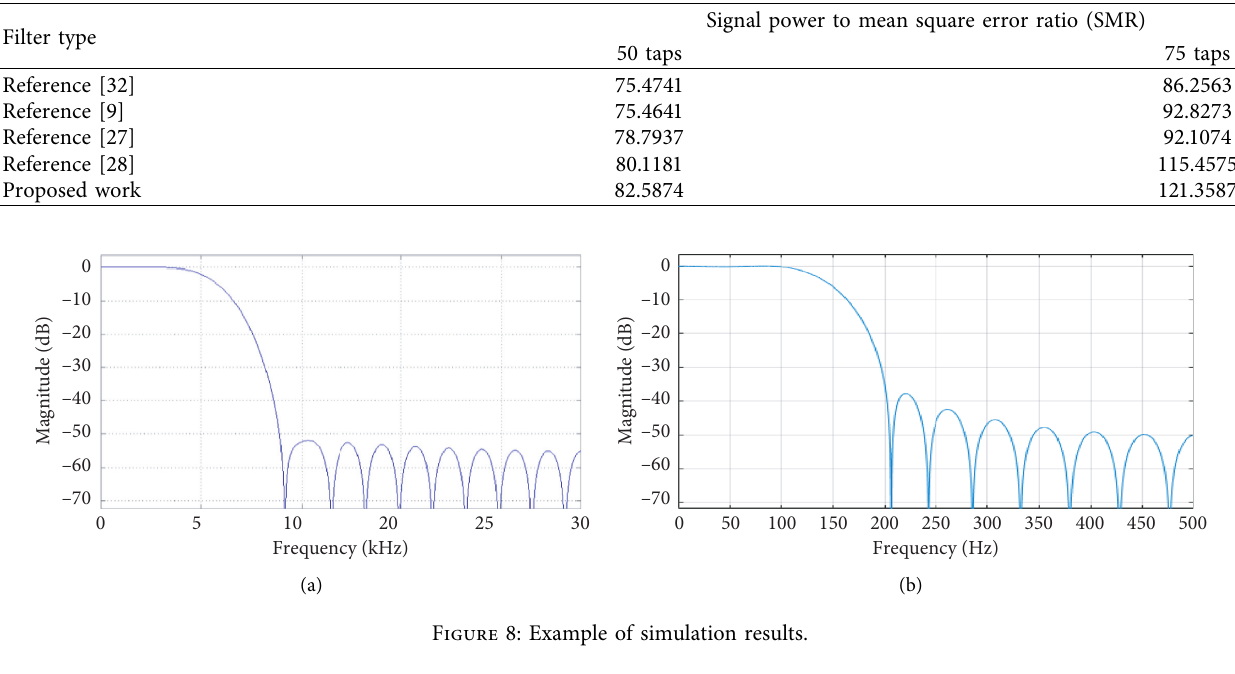
Table 5: SMR performance comparison in the speech signal case.